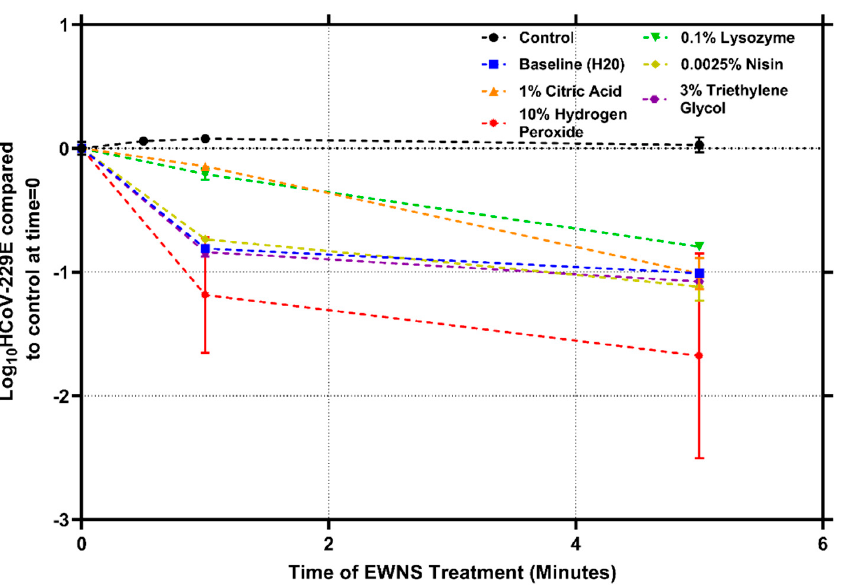
Figure 2. Inactivation of HCoV-229E on surface, after treatment with EWNS. The active ingredient utilized for producing each EWNS for treatment is indicated. Error bars represent standard devia- tion.